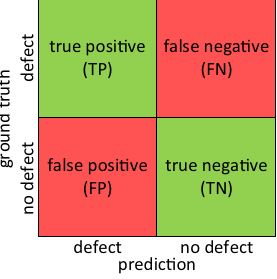
Fig. 5 Confusion matrix for binary